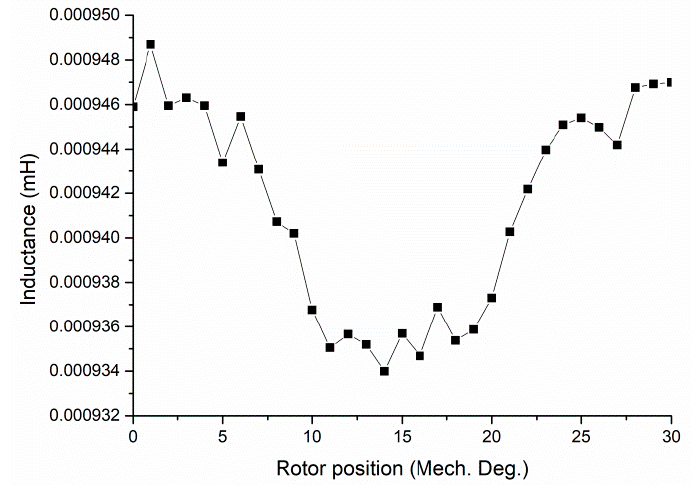
Figure 6. Inductance per turn of FRCPM.